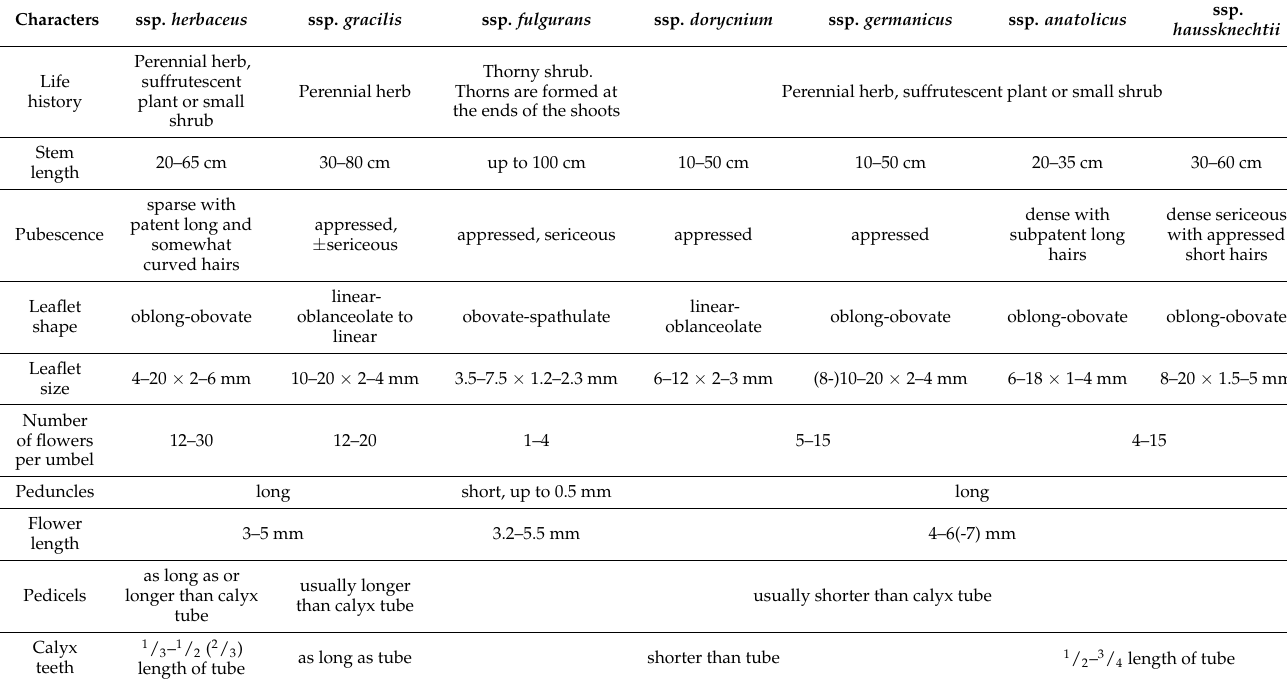
Table 1. Morphological characteristics of subspecies of Lotus dorycnium s.l.